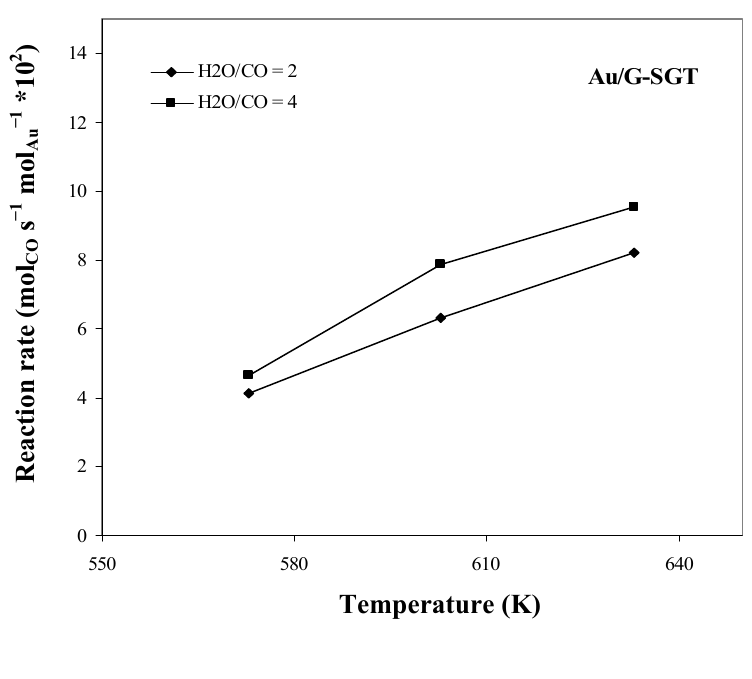
Figure 11. Influence of steam-to-CO molar ratio: Reaction rate versus